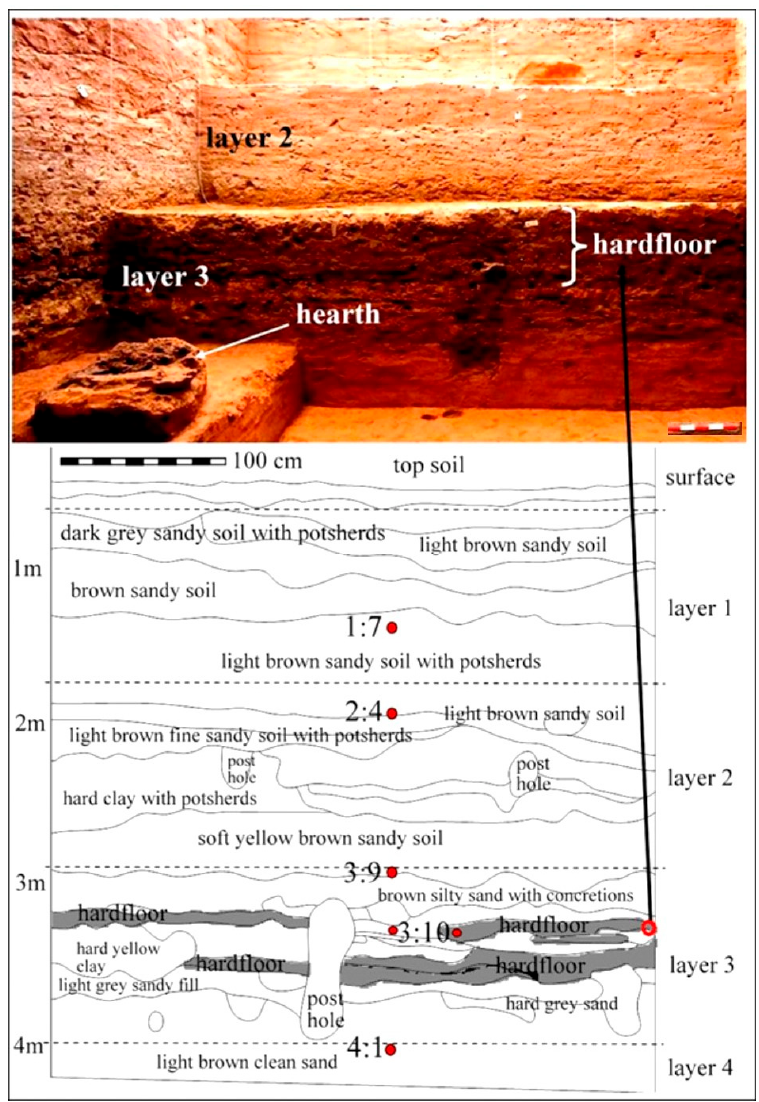
Figure 5. Example of stratigraphic context in HI100 excavation (the red dots indicate the sampling context; layer number: spit number) (Photograph: Nigel Chang; Line diagram: Nelum Kanthilatha). Table 1. Details of the general characteristic of the studied sediment samples. Color identification is based on the Munsell color chart. Period of occupation is based on the macroscopic characteristics identified in the excavations on unpublished excavation reports and available radiocarbon dating [13,16,18].